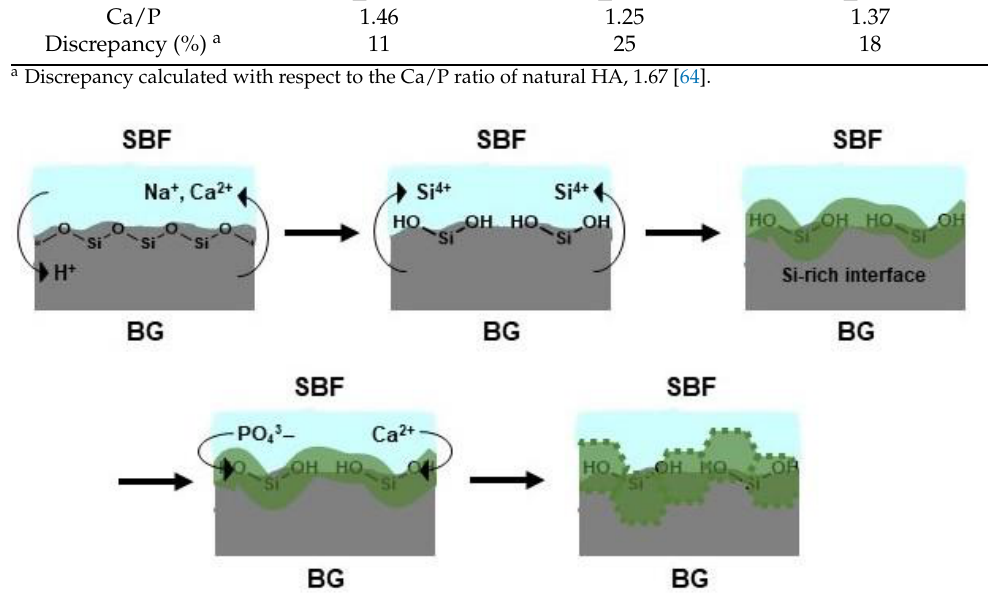
Figure 9. Process of HA formation in BG in the presence of SBF.